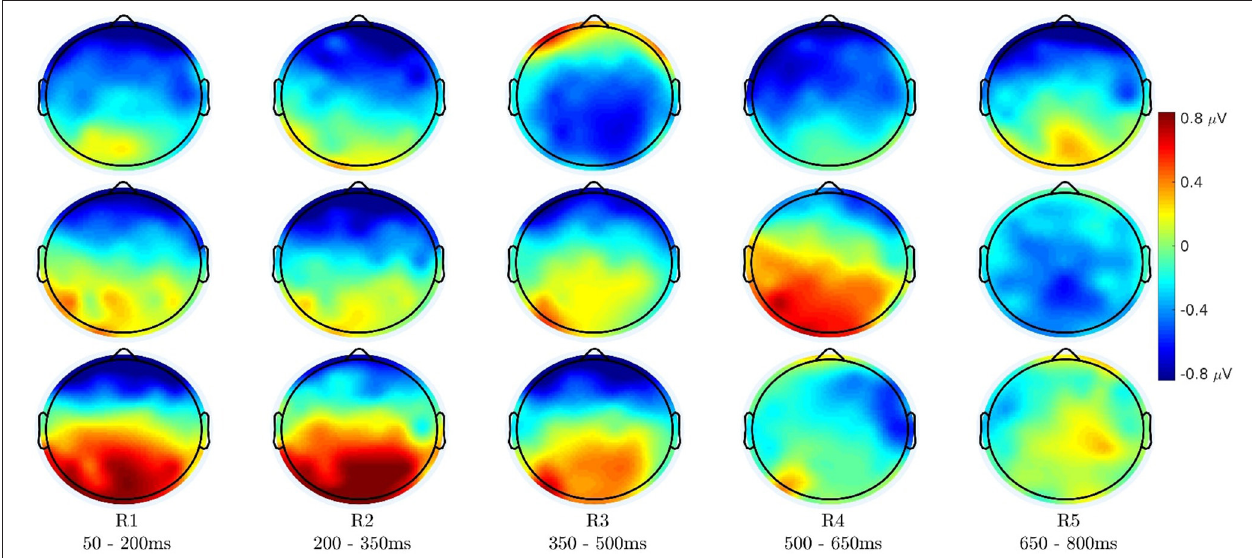
FIGURE 7 | Topography distribution of mean difference of event-related potential (ERP) (grand-average) amplitudes in different time-windows. (Top) Difference of English congruent end-word responses from English incongruent end-word responses (S1). (Middle) Difference of Japanese congruent end-word responses from Japanese incongruent end-word responses (S3). (Bottom) Difference of Japanese end-word responses before learning its meaning from the Japanese end-word responses after learning its meaning (both in congruent